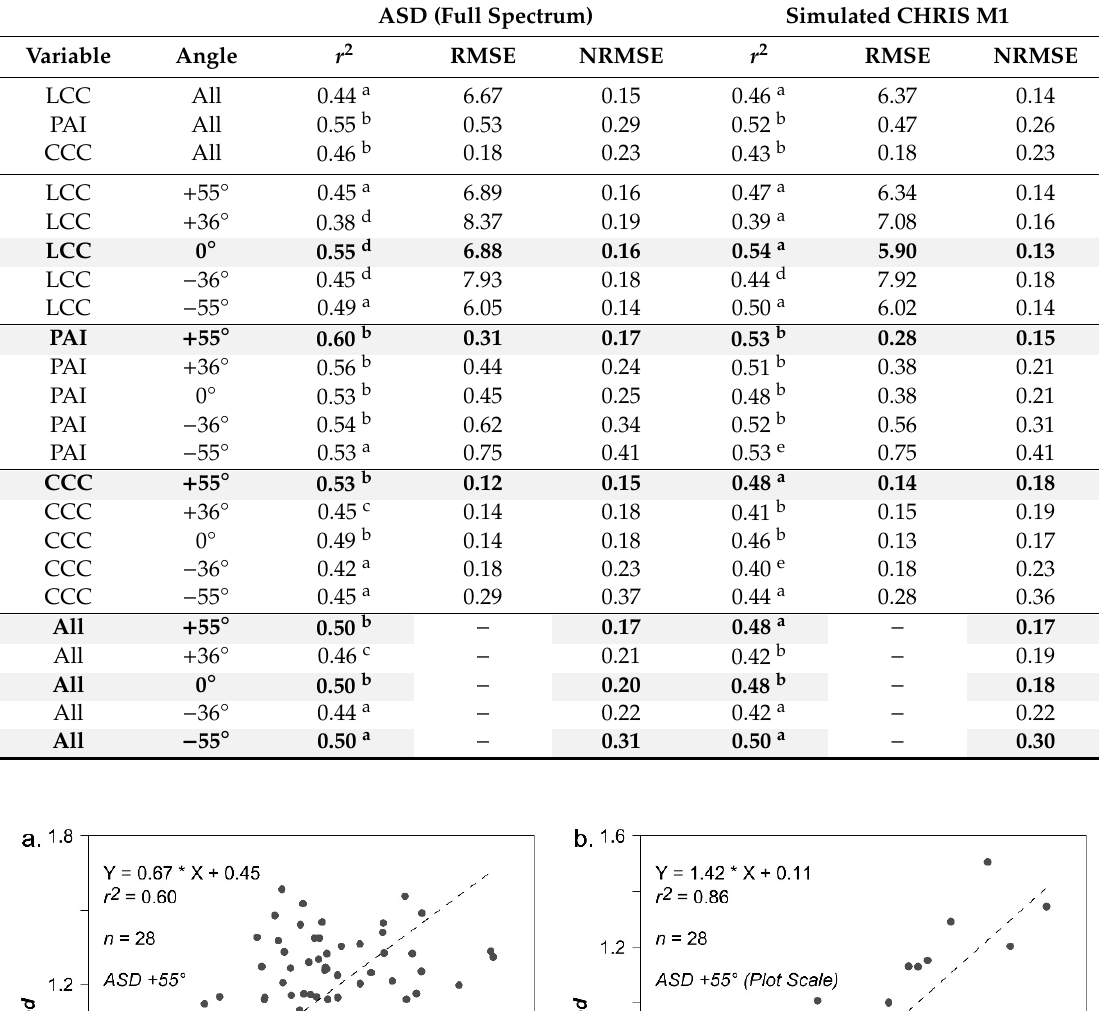
Table 8. PROSAIL LUT-based model performance for plot scale data averaged over all sites and VZAs. RMSE units: LCC ( µ g / cm 2 ); PAI (unitless); CCC (g / m 2 ). NRMSE = RMSE / range of measured